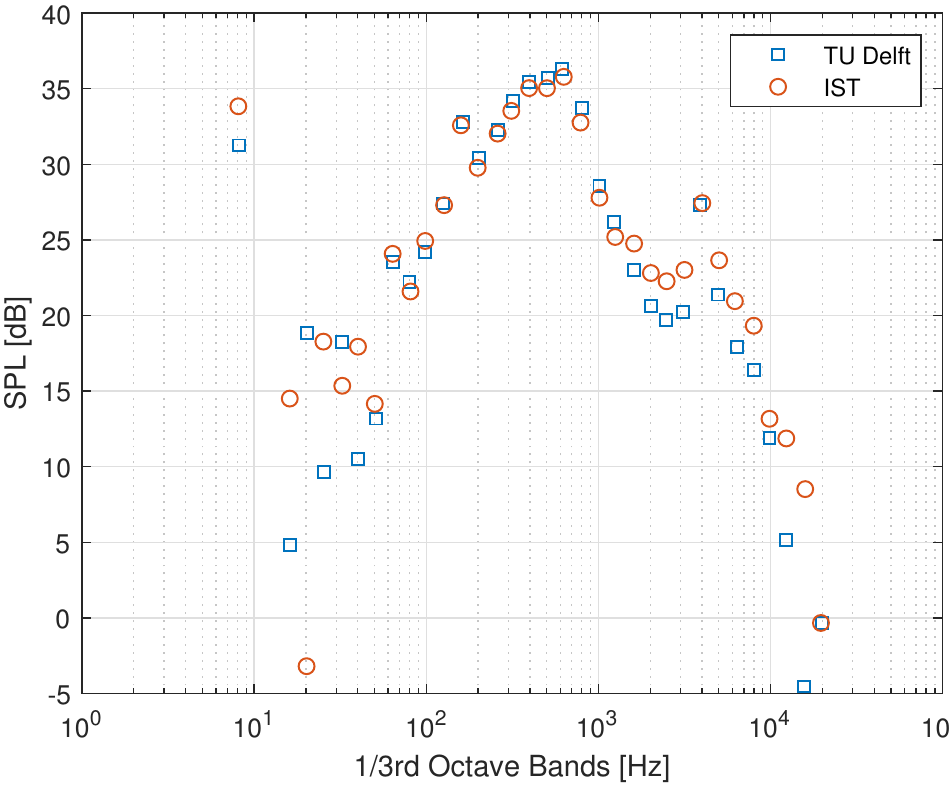
Figure 7. Comparison of 1/3 octave bands between Farassat 1A noise prediction codes from IST and TU Delft of the NACA 0018 wing.